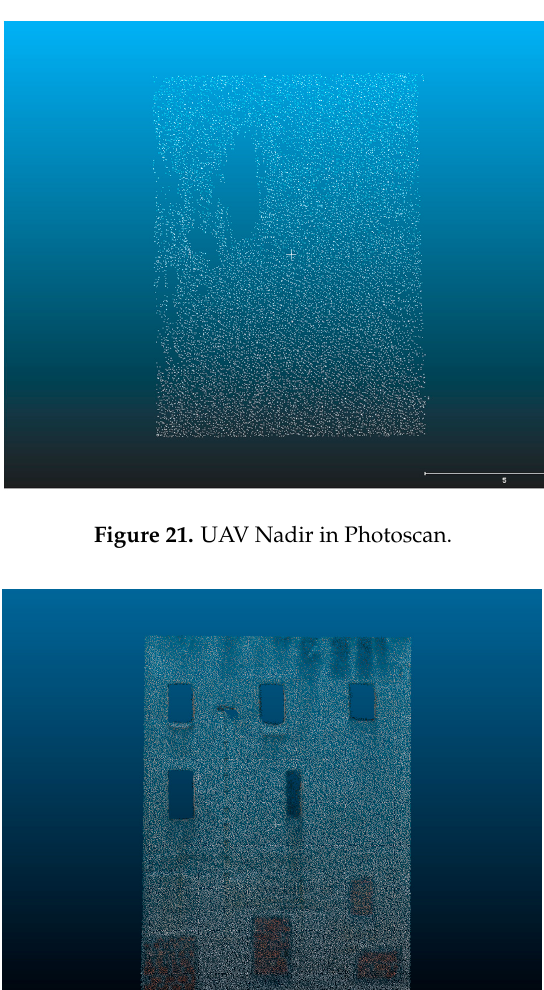
Figure 20. TLS point cloud.